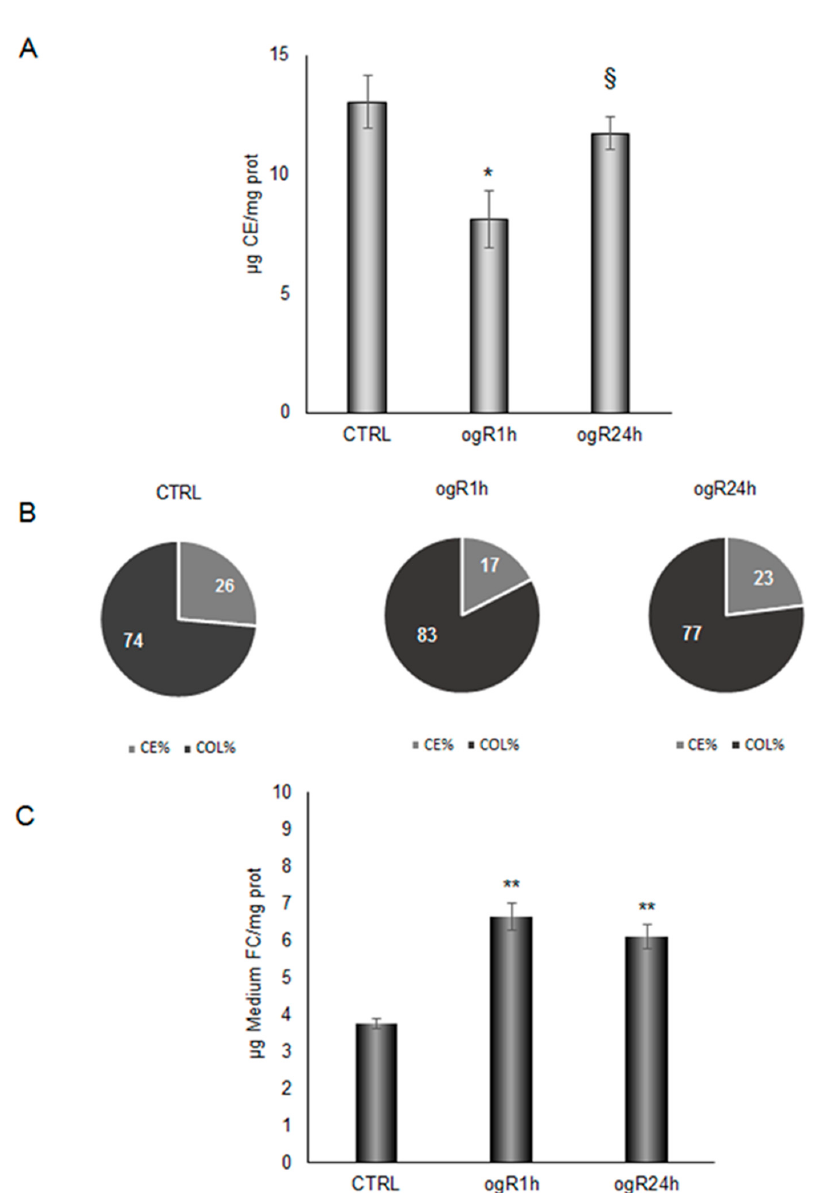
Figure 8. Changes in intracellular and extracellular cholesterol content under OGD/ogR. Cells, after OGD/ogR treatment, were collected and lipids were extracted by different mixture of methanol / chloroform. Free cholesterol (FC) and cholesterol ester (CE) were evaluated by HPLC-ELSD. Panel A represents intracellular CE concentration normalized to protein content. Panel ( B ) depicts with circle charts the molar percentage distribution of intracellular CE and FC. Panel ( C ) reports the cell medium FC content normalized for protein of cells seeded in each analyzed plate. Data are reported as mean ± S.E. ( A , C ) from three independent experiments, * p < 0.05, ** p < 0.01 vs. control; § p < 0.05 vs. ogR1h.